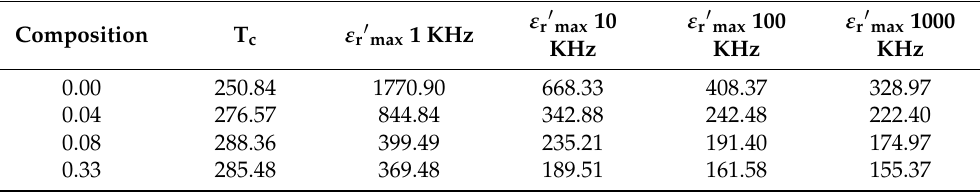
Table 5. The ferroelectric properties of the Ba 0.54 Na 0.46 Nb 1.29 W (0.37-x) Mo x O 5 solid solution